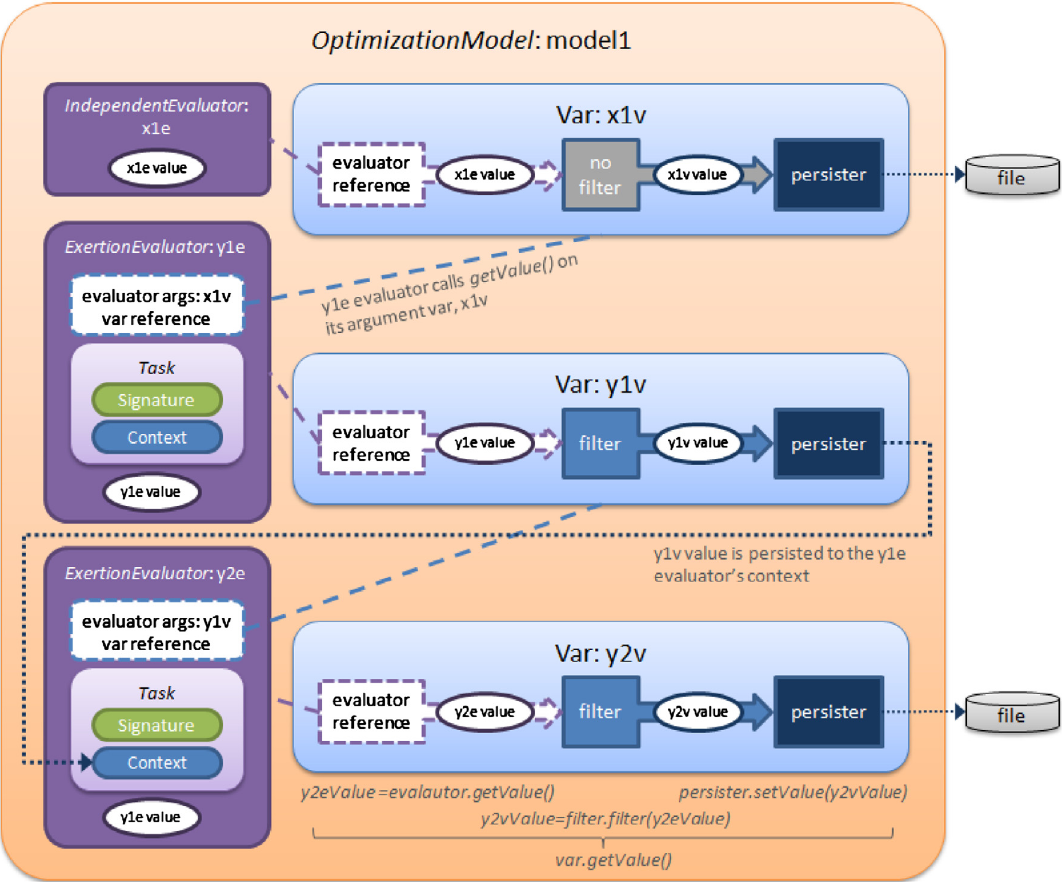
Figure 4. An OptimizationModel is a collection of Var objects; each var references an evaluator and may be referenced by other vars to form composite